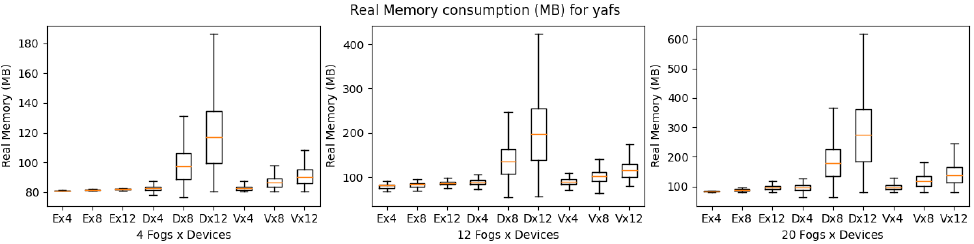
Figure 18. Real memory consumption for YAFS during simulation (E: eHealth; D: DCNS; V: